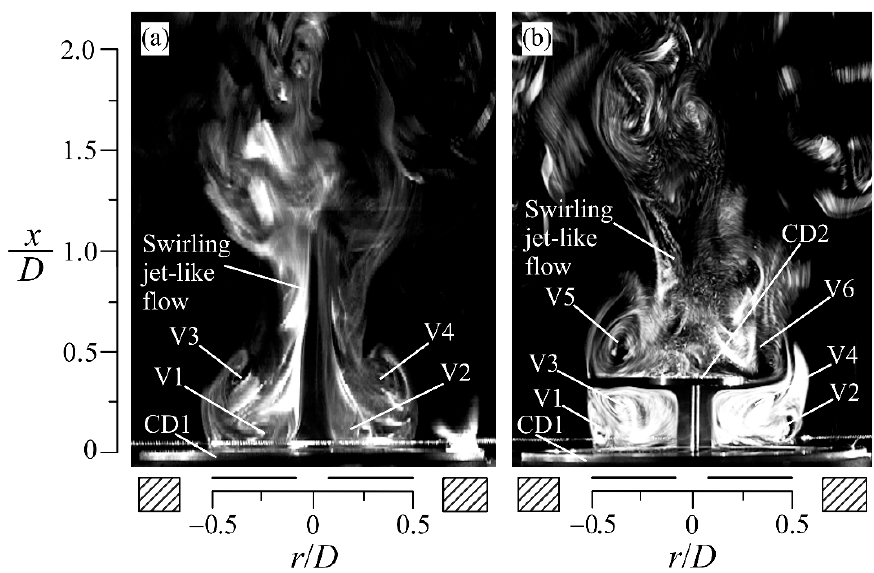
Figure 3. Instantaneous smoke flow patterns in axisymmetry plane of swirling double-concentric jets. Re c = 280, Re a = 480, and S = 0.432. ( a ) One centerbody, ( b ) two centerbodies. Exposure time: 20 ms.